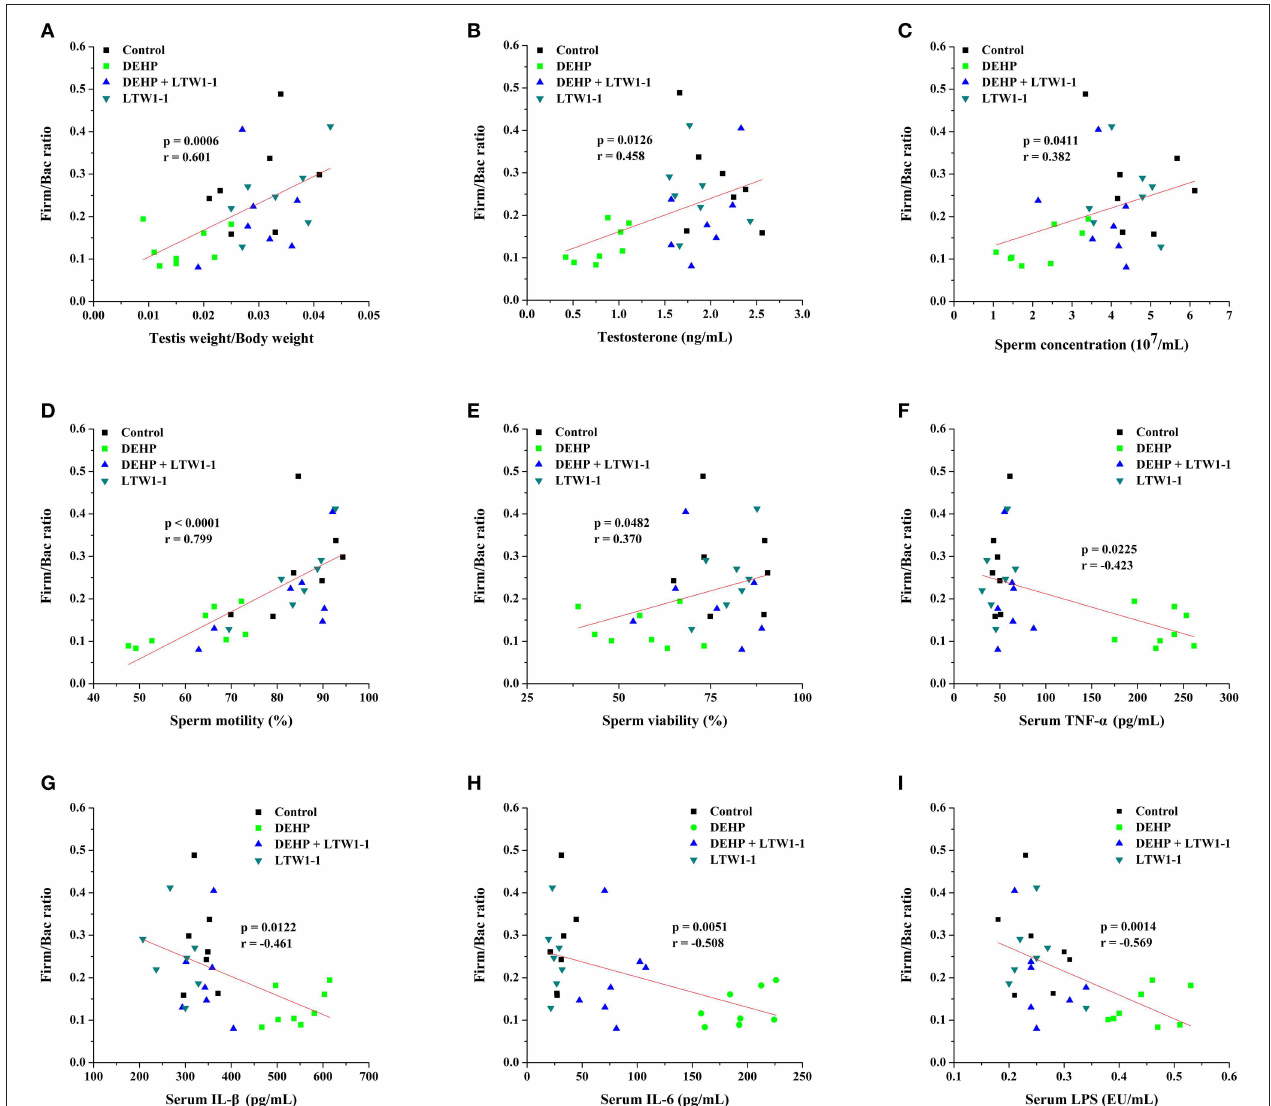
FIGURE 7 | Spearman correlation analysis between the Firm/Bac ratio and testicular function parameters and inflammation were performed. The data were determined by Spearman’s rho, which correspond to the “ r ” and “ p ” values, respectively, as shown in each plot. The Y-axis indicates the Firm/Bac ratio for each mouse compared with Relative testis weight (A) , Testosterone (B) , Sperm concentration (C) , Sperm motility (D) , Sperm viability (E) , TNF- α (F) , IL-1 β (G) , IL-6 (H) , and LPS (I) ( n =